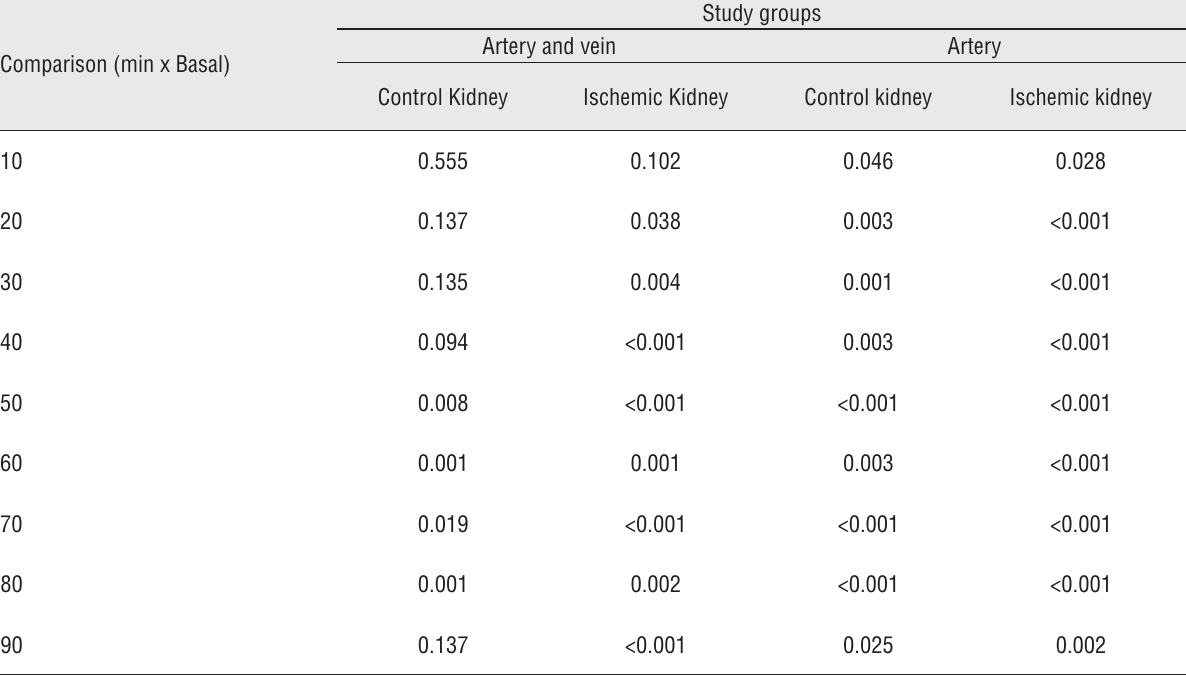
Table 1 - Estimated proportions for the presence of lesion in the biopsies performed.